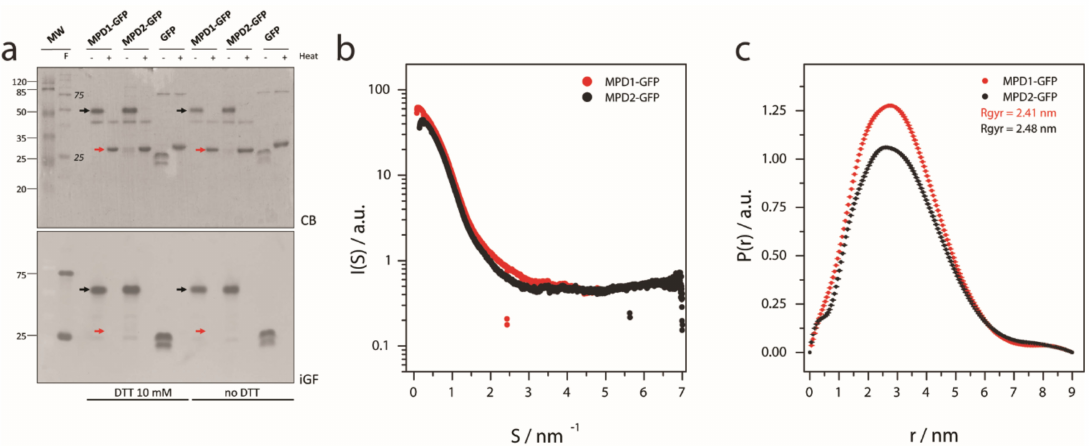
Figure 3. Oligomerization state of MPD domain for TRPV1 and TRPV2. ( a ) SDS-PAGE of boiled and not boiled MPD-GFP samples (heat +/ − , respectively) and in the presence/absence of reducing agents observed by Coomassie blue (CB, top) and in-gel fluorescence (iGF, bottom; F stands for fluorescent molecular weight (MW) marker). Black and read arrows indicate the oligomeric and monomeric bands, respectively. ( b ) SAXS scattering plot for the MPD-GFP constructs for TRPV1 and TRPV2. ( c ) Probability distribution function for the MPD-GFP constructs for TRPV1 and